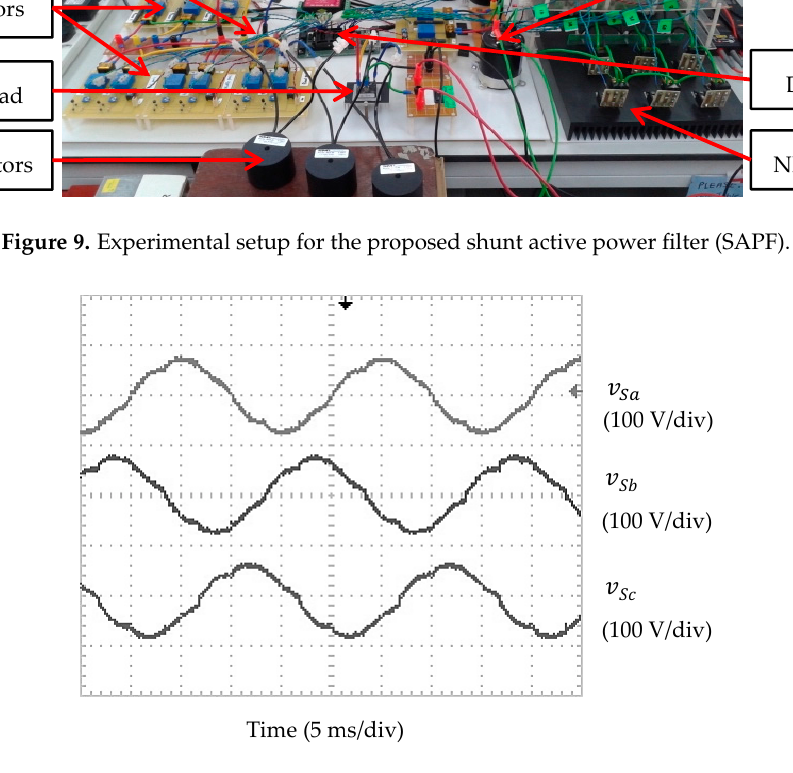
Figure 10. Steady-state experimental waveforms of the three-phase non-sinusoidal source voltage (phase) with THD = 6.91%. Table 4. THD values of source current i S in all phases resulted from SAPF utilizing each reference current generation algorithm (Experimental Result).